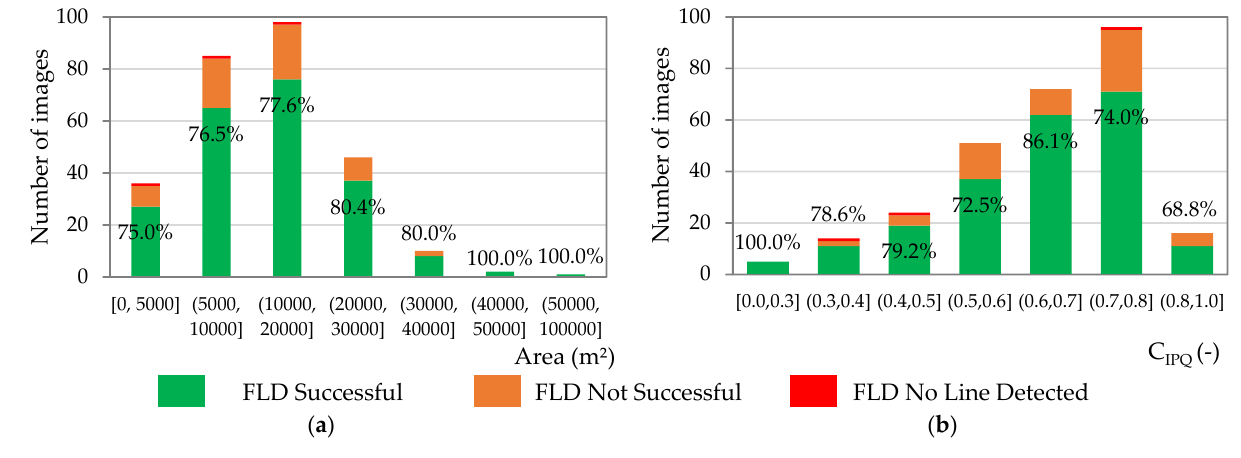
Figure 18. Results of FLD with parameters of ( a ) the shape area (different class widths) and ( b ) the compactness factor CIPQ; percentages describe the success rate of the FLD per interval.